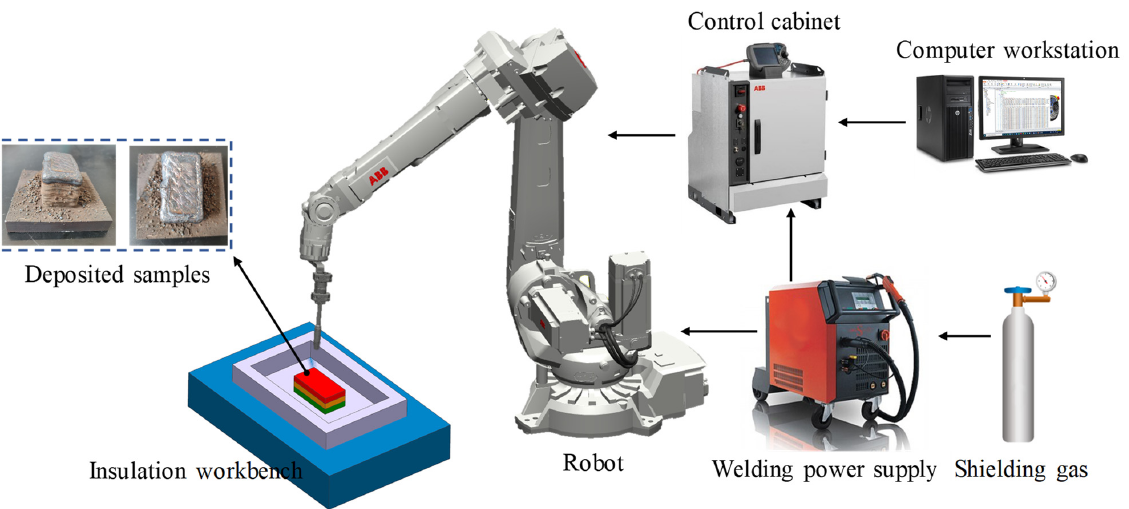
Figure 1. Schematic diagram of the robotic GMAW-based additive manufacturing system.